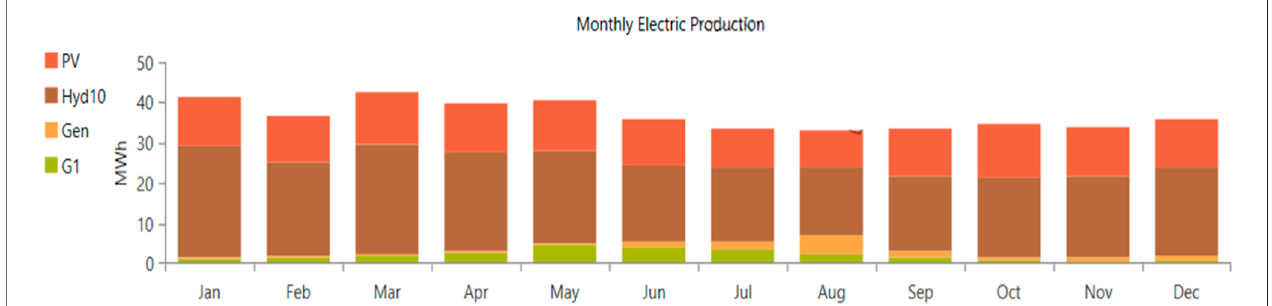
FIGURE 6 | Monthly average electric